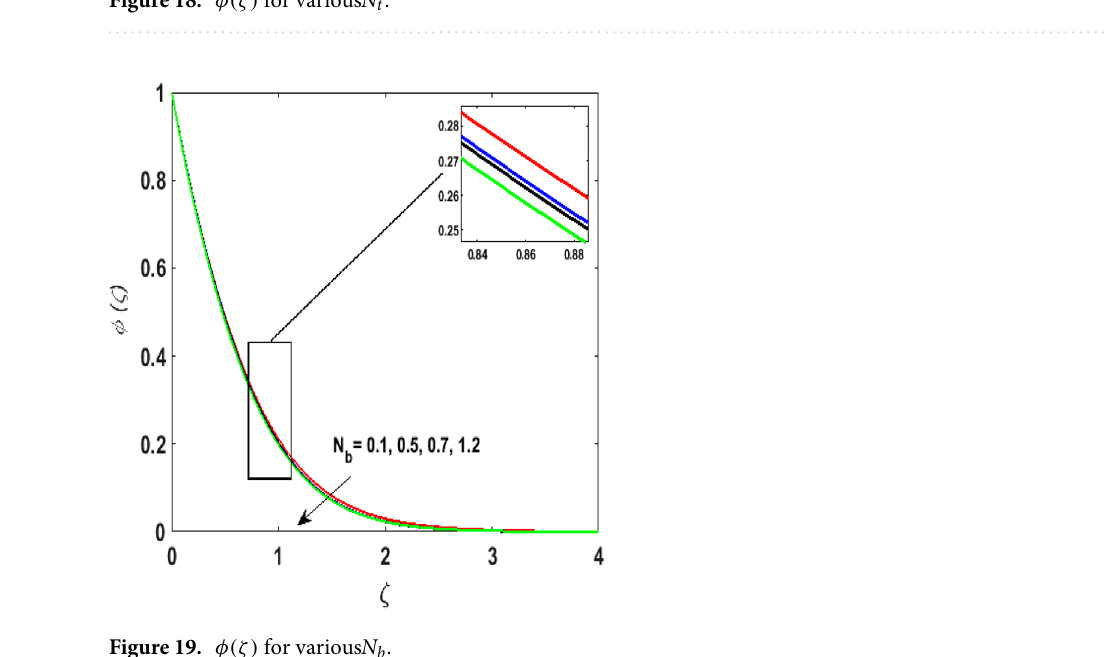
Figure 18. φ(ζ) for various N t .